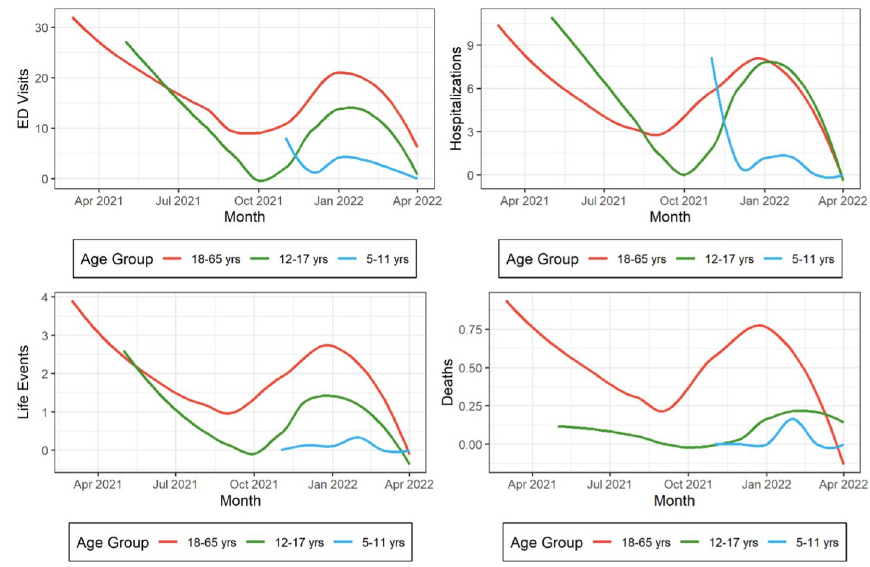
Fig 1. Monthly crude cumulative reported rate of sAEFI types occurring within 42 days after SARS-CoV2 vaccination among recipients of BNT-162b in adults ( > 17 years), and 5–11 and 12–17-year-old children. Reported rates are expressed per 100,000 patients fully vaccinated. Temporal trends have been smoothed using local polynomial regression lines. A slight increase in all rates reflects the concomitant delta wave in US during winter 2021. The scale is reduced (0–4 per 100,000 & 0–1 per 100,000 for life-threatening events and deaths respectively) in insets to demonstrate minimal risk increase of these events concurrently as well.